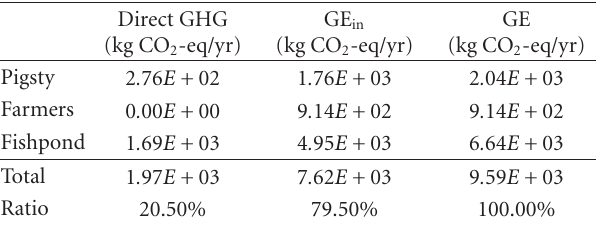
Table 6: GE of the conventional animal husbandry